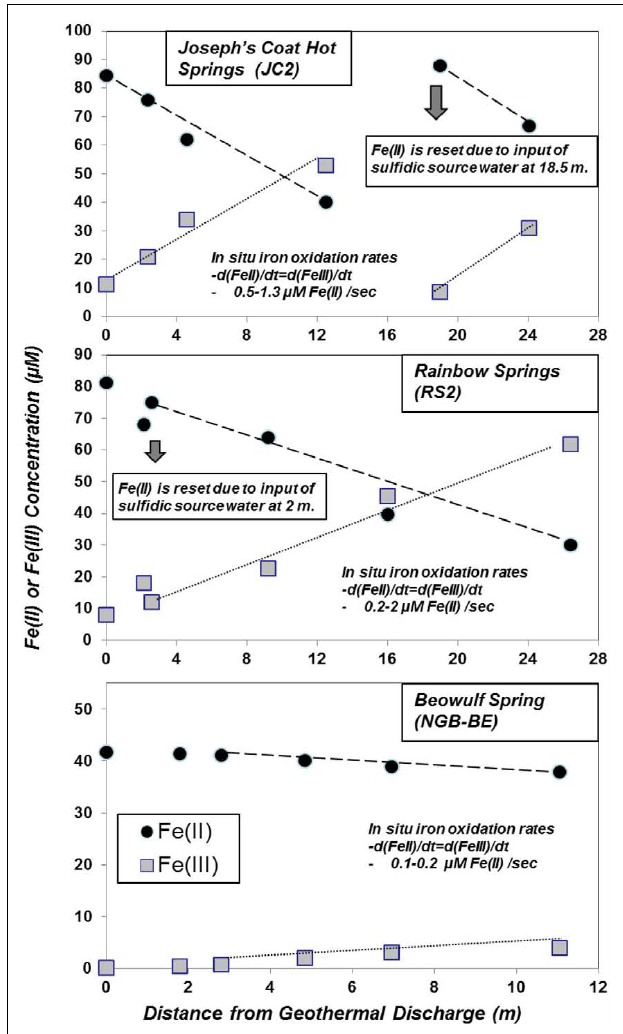
FIGURE 3 | Profile of Fe(II) oxidation in acidic geothermal springs at Joseph’s Coat Hot Springs (JC2), Rainbow Springs (RS2) and Norris Geyser Basin ( Beowulf Spring) plotted as the disappearance of Fe(II) or the production of Fe(III) as a function of time (or distance) within the outflow channel. The total soluble Fe at any position is the sum of Fe(II) and Fe(III), which agreed favorably ( < 10% difference) with total Fe determined using inductively coupled plasma spectrometry [ICP; total Fe values of JC2A, RS2A, and BEA are ∼ 100, 90, and 40 μ M, respectively]. In JC2, ∼ 45% of the total ferrous Fe is oxidized to Fe(III) at sampling position D, corresponding to a 35-s travel time [sampling positions JC2E and RSC correspond to a second spring discharge, which resets the concentration of